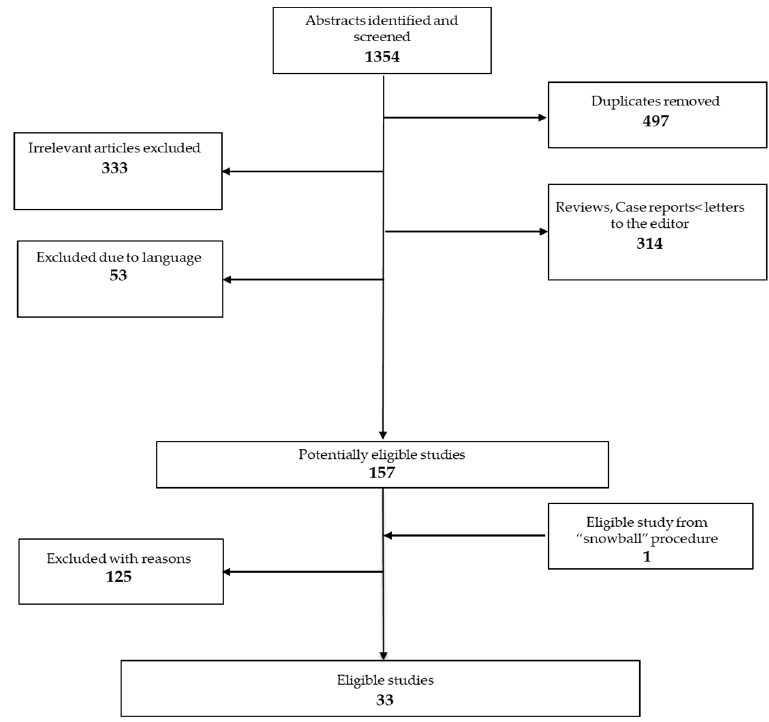
Figure 1. PRISMA flow chart.